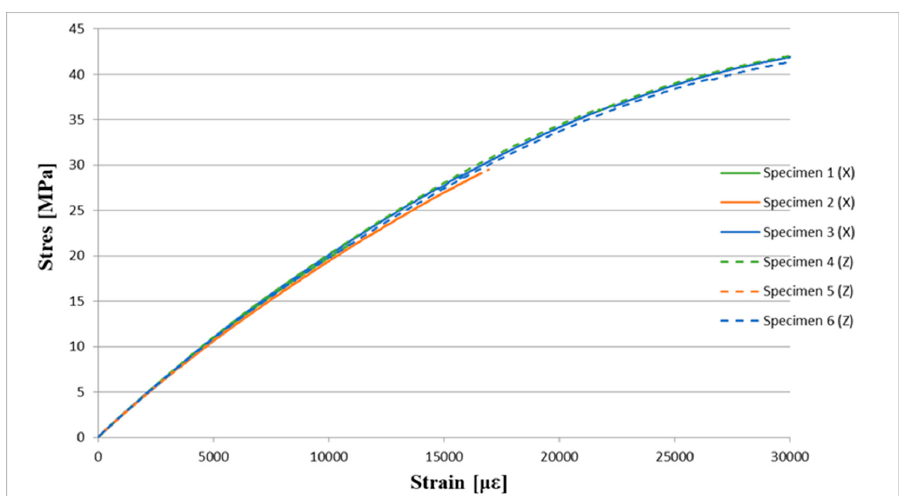
Figure 15. Stress-strain curves for six specimens made of Rigur material, three printed horizontally (X) and three vertically (Z).